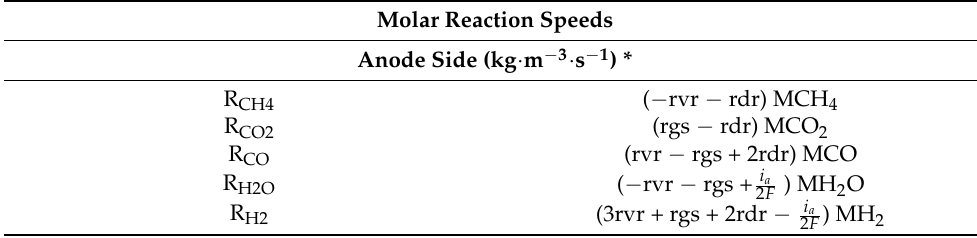
Table 4. Expression of reaction rate of molar species present in